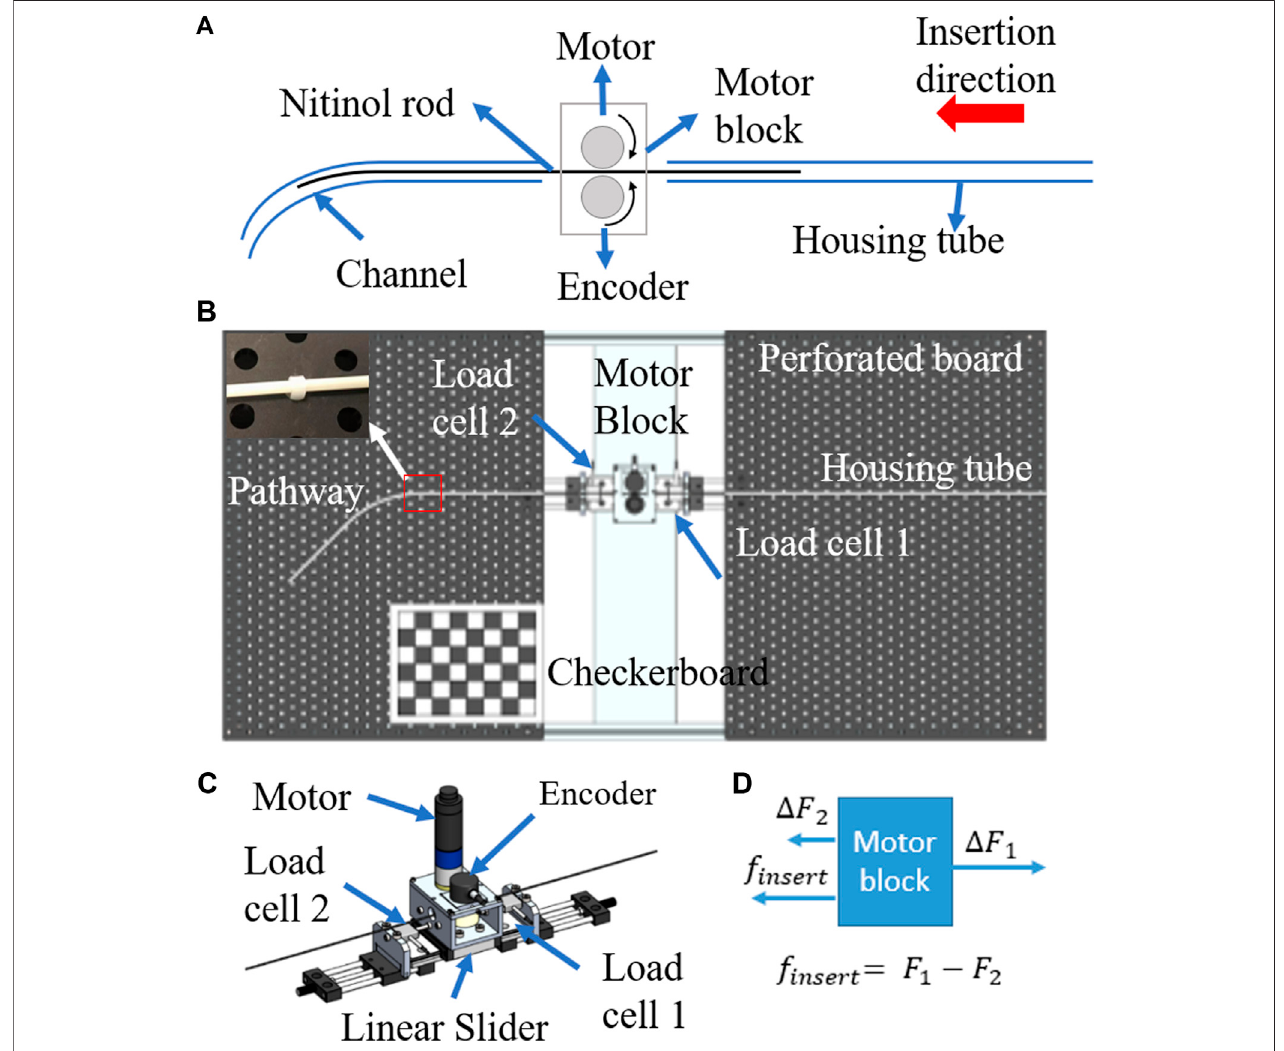
FIGURE 2 | (A) schematic diagram of experimental setup, (B) experimental setup, (C) the design of the motor block, (D) force diagram of the motor block.